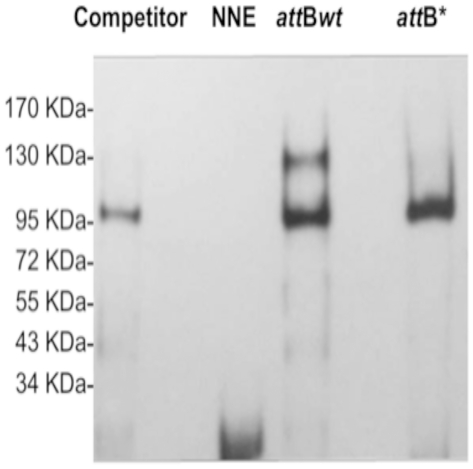
Enzyme electrophoretic mobility shift assay using HEK293 cell nuclear
extracts.Competitor: HEK293 cell nuclear extracts incubated with the
attBwt sequence together with poly-dIdC and
unlabeled attBwt as specific competitor. NNE:
attBwt sequence without nuclear
extracts. attBwt: Nuclear extracts
from HEK293 cells incubated with a wild type attB
sequence and poly-dIdC. attB*: Nuclear extracts
from HEK293 cells incubated with a mutant attB sequence
and poly-dIdC.